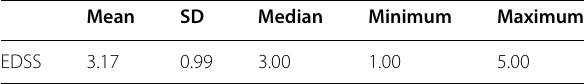
Table 9 EDSS in MS patients Table 11 Relation between cognitive impairment and whole brain, thalamic and multiple structure